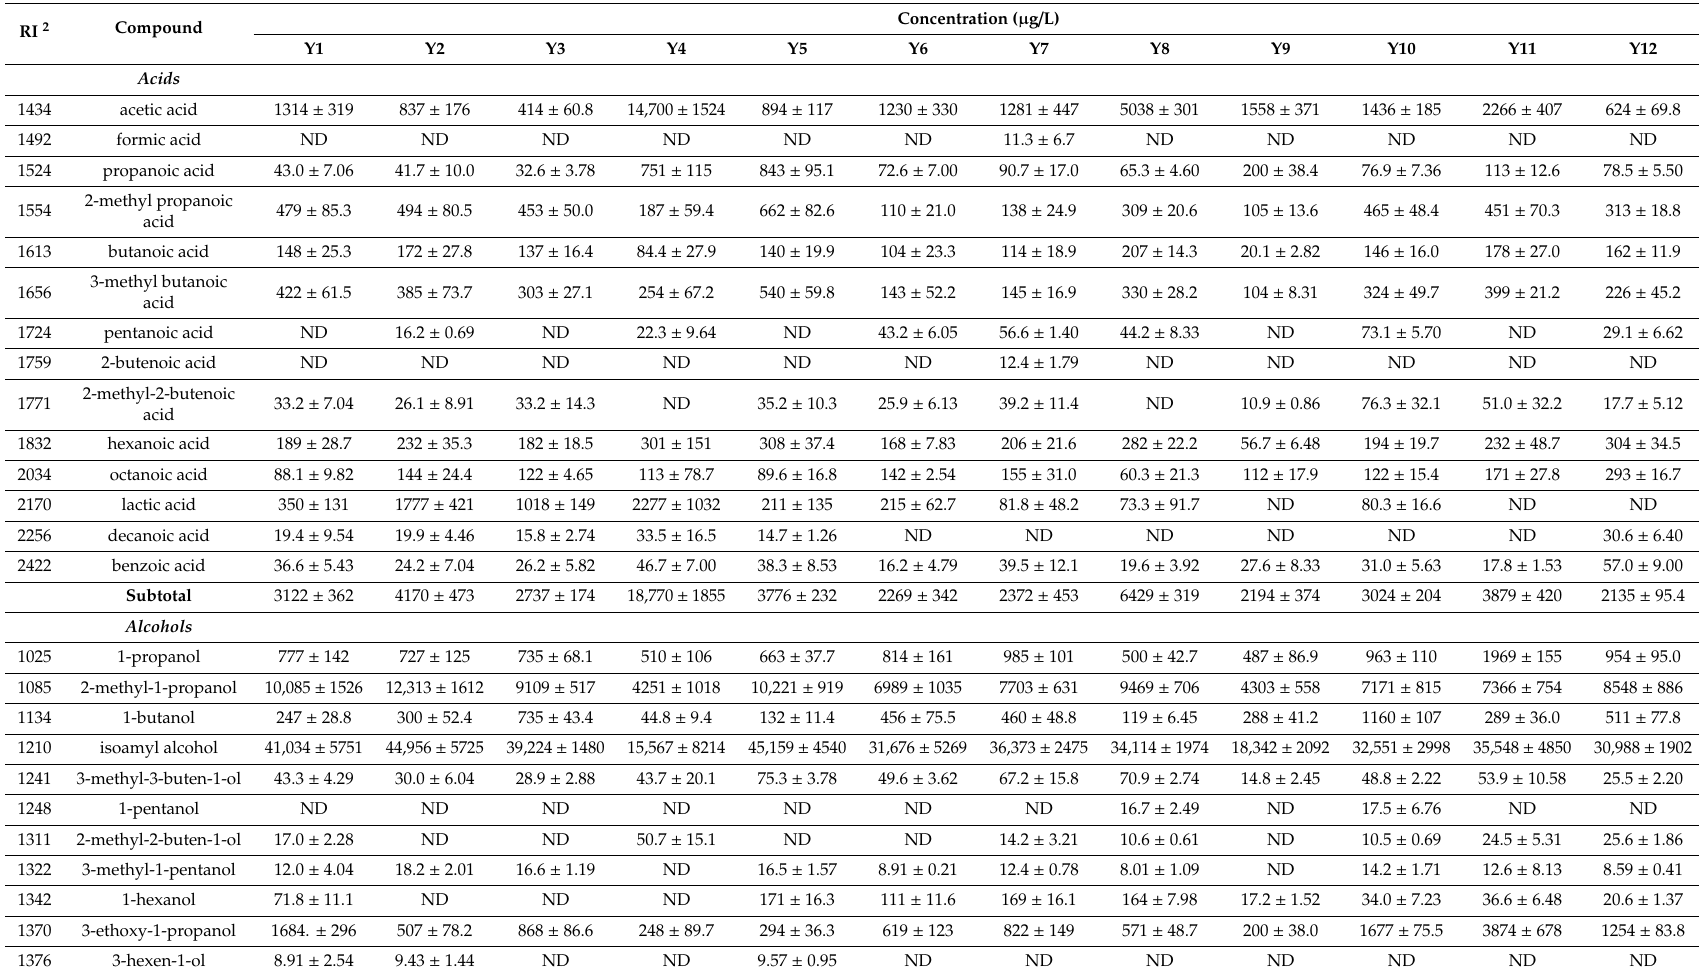
Table 5. Volatile compounds of the 12 yakju samples 1